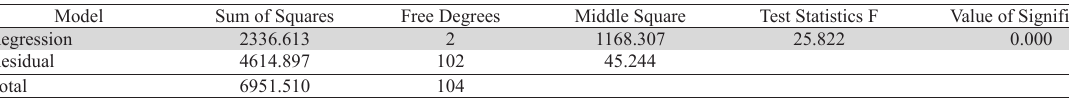
Structural Model Simultaneous Test Results 1